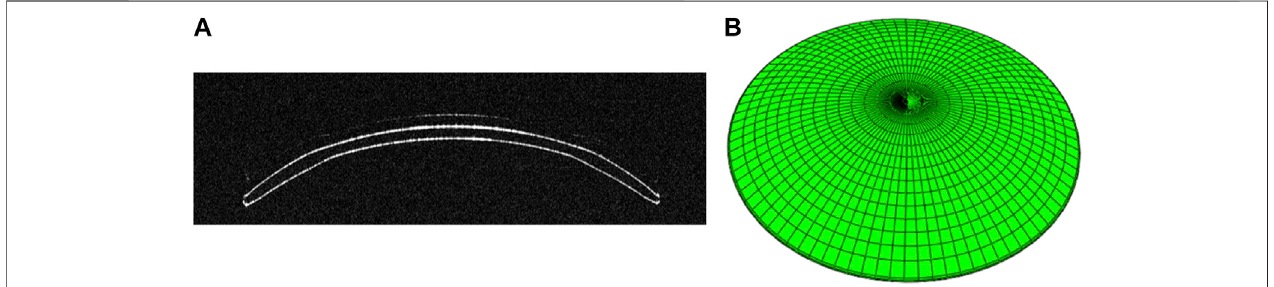
FIGURE 1 | (A) OCT B-Scan image of ortho-k lens from the Optimec is830. (B) Three-dimensional model of ortho-k lens.